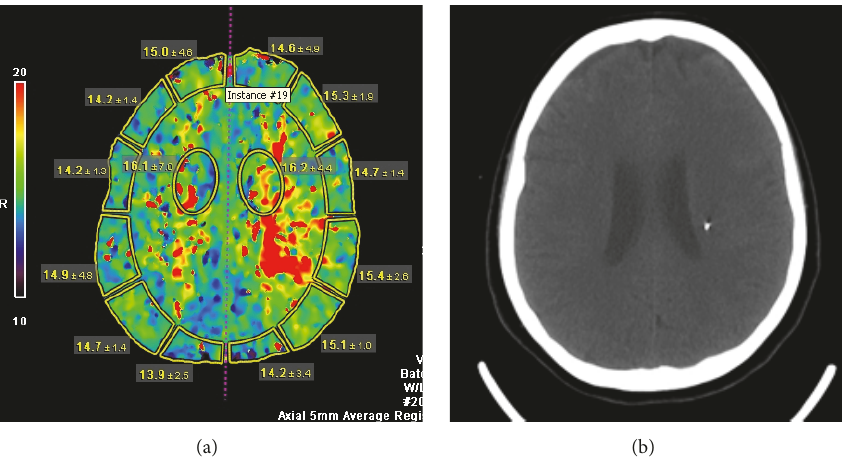
Figure 1: (a) prolongation of the TTP signal in the left central Rolandic white matter. (b) A plain CT scan showing the tip of the BPM in the area of the prolongation of the